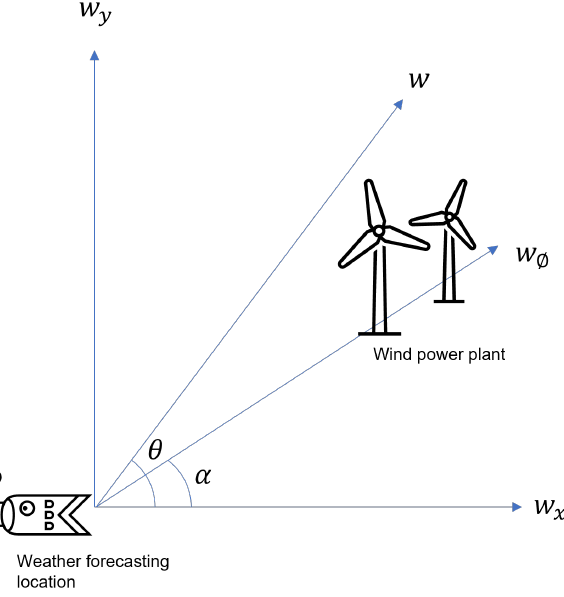
Figure 7. Estimation of wind speed at wind power plant based on east–west wind speed ( W x ) and north–south wind speed ( W y ) at weather forecasting location.